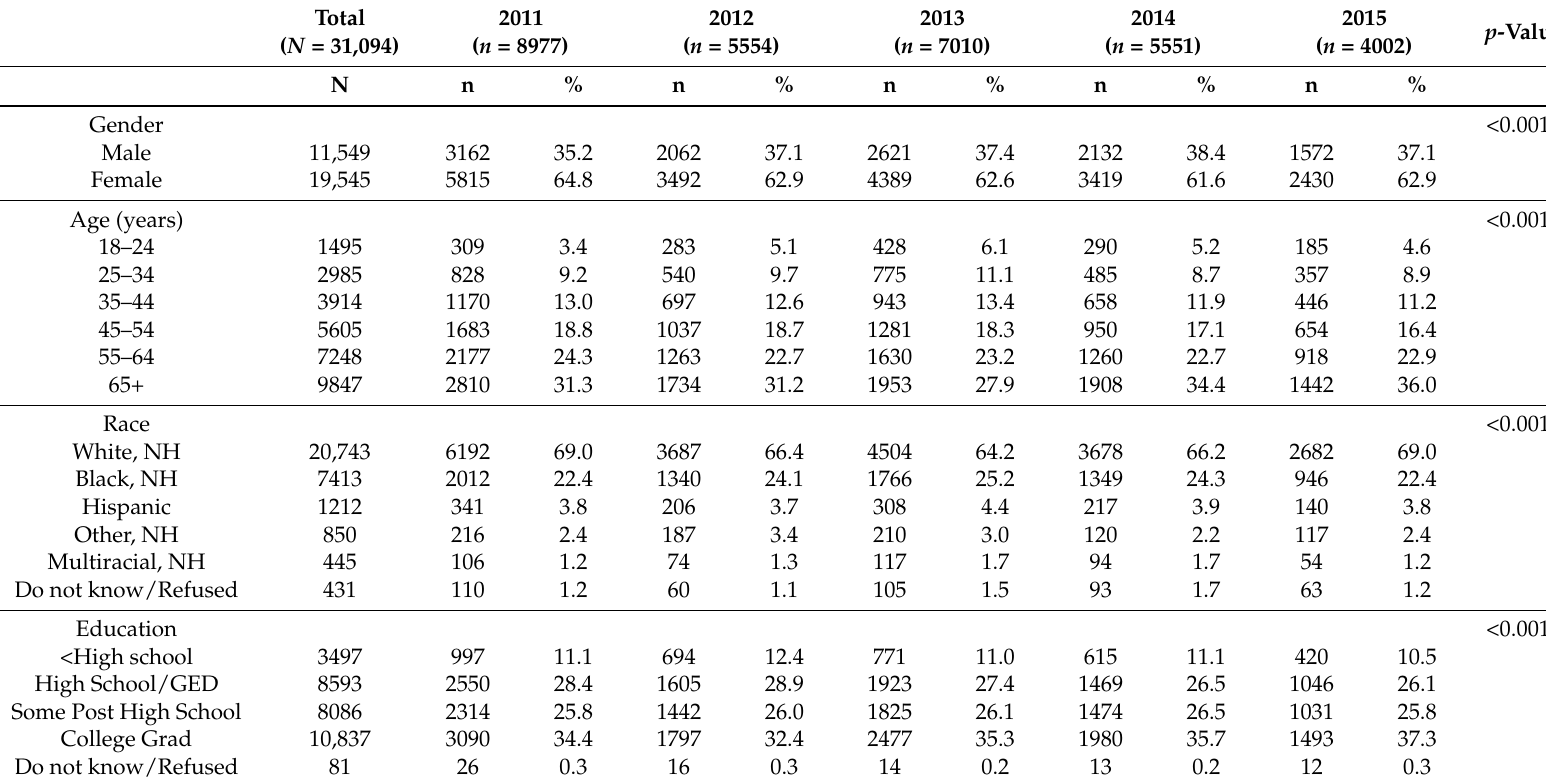
Table 1. Socio-demographic characteristics and HIV risk situations of survey respondents to the question “Have you ever been tested for HIV?” in Georgia: 2011–2015 BRFSS